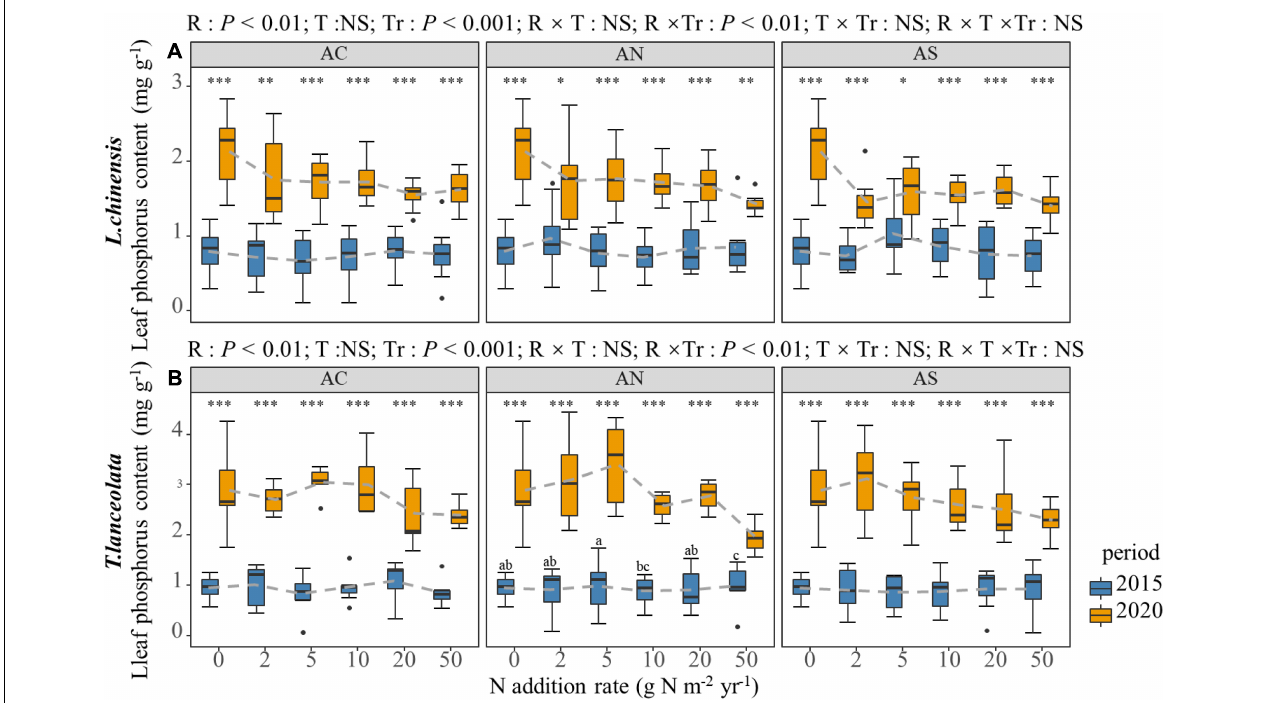
FIGURE 2 | Effects of short- and long-term nitrogen deposition on LP of two species: (A) Leymus chinensis ; (B) Thermopsis lanceolata . The three-way ANOVA was used to test the effects of Pr, T and R on LP. The effects of the nitrogen compound type alone and with nitrogen addition rate and year on LP are not significant (NS, P > 0.05), thus one-way ANOVA (Tukey’s HSD) and t -tests are used to test the effects of nitrogen addition rate and year on LP. Different lower-case and upper-case letters indicate significant differences ( P < 0.05) in LN among nitrogen addition rate in the 2015 and 2020 plots, respectively. The asterisk above the picture indicates the significant difference between the two years under each nitrogen addition rate. Note: ∗ P < 0.05; ∗∗ P < 0.01; ∗∗∗ P < 0.001. CK: non-fertilizer control = 0, N1 = 2, N2 = 5, N3 = 10, N4 = 20, and N5 = 50 kg N ha − 1 yr − 1 ; AC (NH 4 HCO 3 ), AN (NH 4 NO 3 ), AS [(NH 4 ) 2 SO 4 ]. The gray dashed line is the connection of the mean